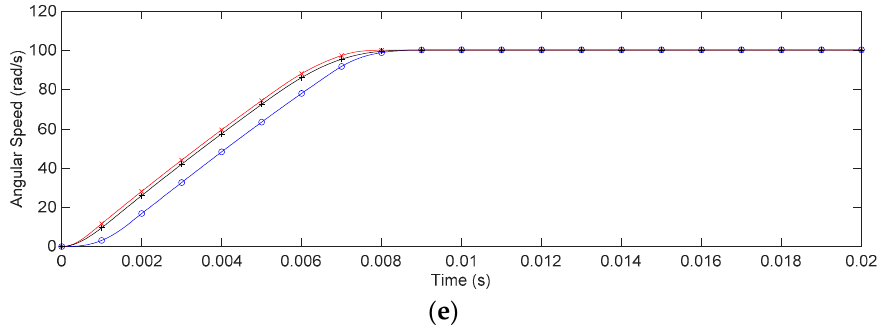
Figure 4. Simulation results of the proposed controller, the numerical method, and the implicit MPC with the second set of r and w : ( a ) motor currents from 0 to 1 s, ( b ) angular speeds of the motor rotor from 0 to 1 s, ( c ) angle of the motor rotor from 0 to 1 s, ( d ) motor currents from 0 to 0.02 s, ( e ) angular speeds of the motor rotor from 0 to 0.02 s.